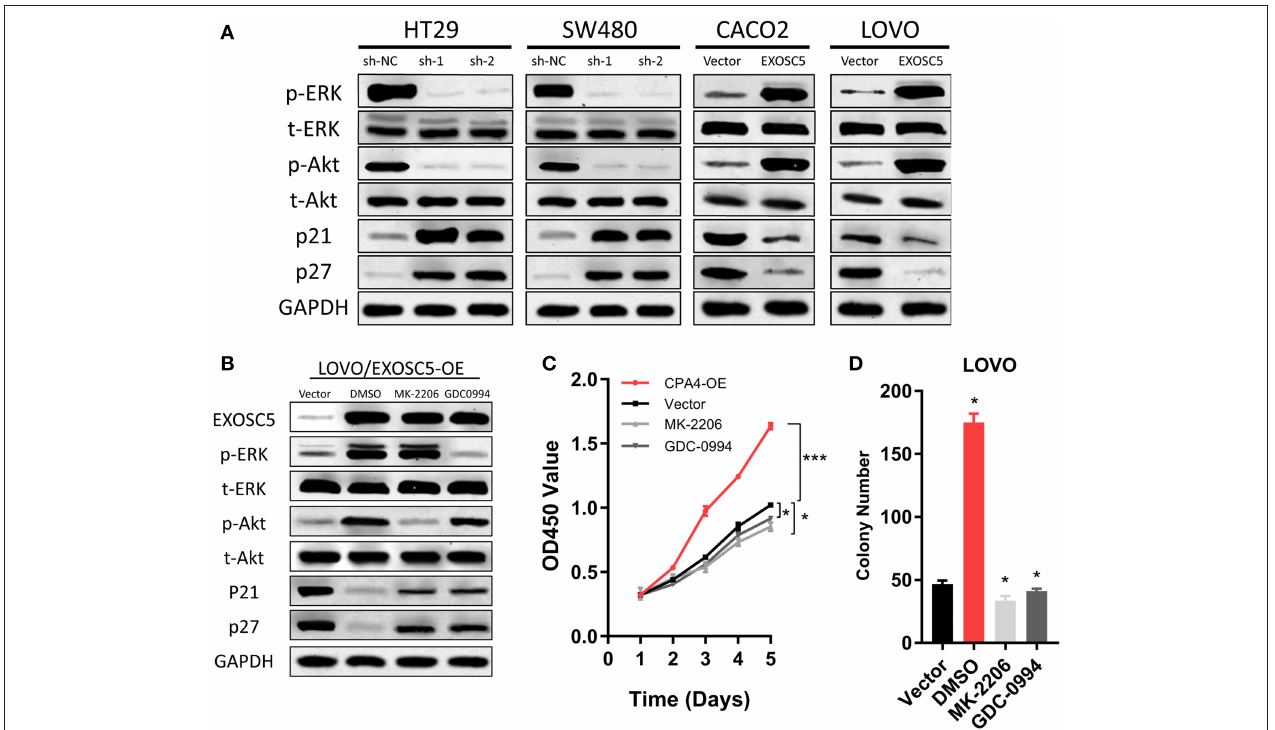
FIGURE 5 | EXOSC5 activated AKT and ERK signaling pathways in CRC cells. (A) The levels of phosphorylated ERK, total ERK, phosphorylated Akt, total Akt, cleavages of caspase-9, and caspase-3 were detected in EXOSC5 knockdown and overexpression cells by western blot analysis. GADPH was used as the loading control. (B) LOVO cells with EXOSC5 overexpression were treated with the AKT inhibitor MK-2206, the ERK inhibitor U01226 for 24h. The cells were harvested to measure the expression levels of the indicated proteins by western blot. (C,D) Proliferation ability of LOVO cells with EXOSC5 overexpression was determined by CCK-8 (C) and colony formation assay (D) after treatment with MK-2206, GDC-0994, or DMSO. Error bars represent mean ± SD from 3 independent experiments. (* p < 0.05, *** p <